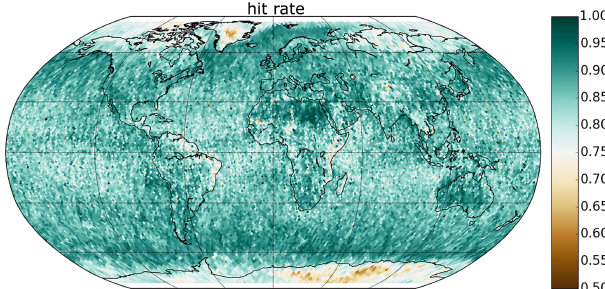
Figure 7. Peak hit rate results for the CLARA-A2 cloud mask achieved after filtering the CALIOP cloud mask with the cloud op- tical thickness value of 0.225. Same underlying matchup data set as in Fig. 2. Results are presented in a Fibonacci grid with 75km